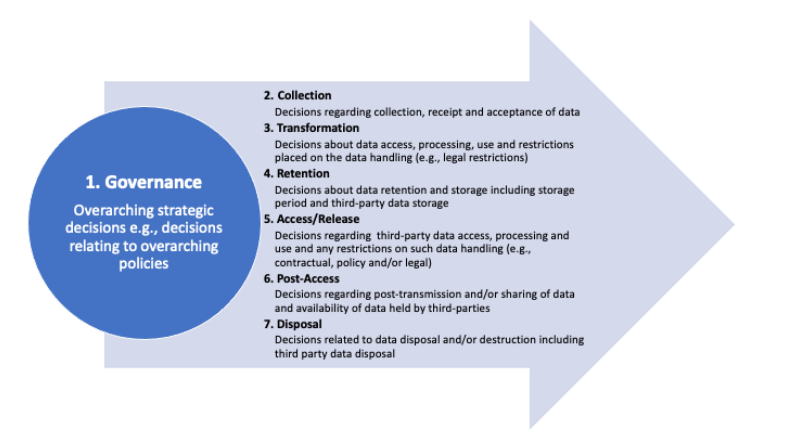
Figure 2. 7-stage Data Lifecycle (7-DL), adapted from Altman et al.